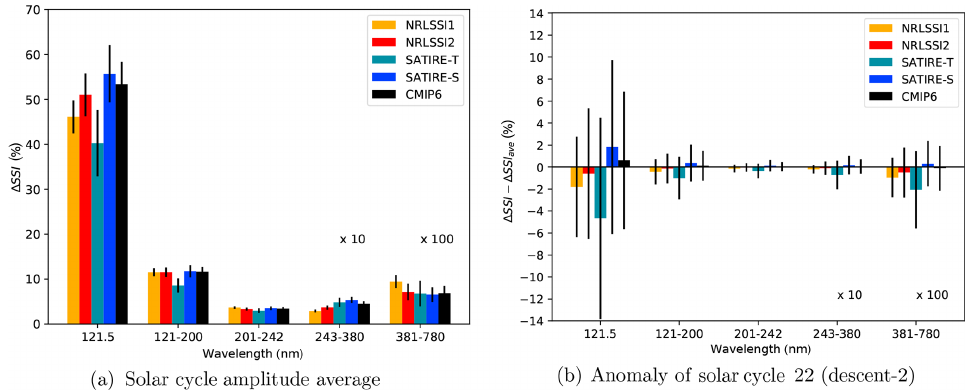
Figure 2. (a) Averaged SSI variations for solar cycle amplitudes relative to ATLAS-3 ( (cid:49) SSI) in percent for the Lyman- α (121.5nm), far-UV (121–200nm), Herzberg continuum and Hartley bands (201–242nm), Hartley and Huggins bands (243–380nm) (multiplied by a factor of 10), and visible (381–780nm) (multiplied by a factor of 100) spectral ranges, with the 95% confidence interval given as error bar. (b) Anomaly of SSI variations for solar cycle 22 (descent-2) with respect to the averaged solar cycle shown in (a) .